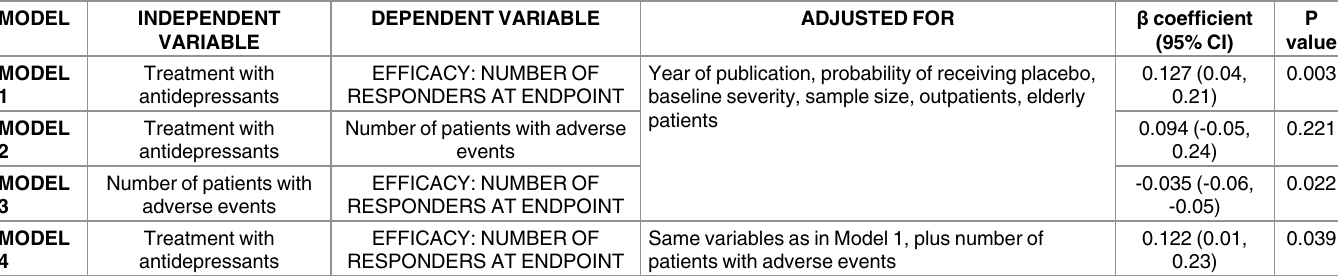
Table 3. Baron and Kenny mediational